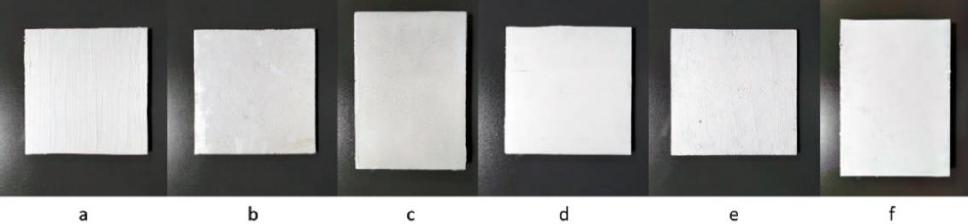
Figure 1. Investigated RR and diffusive coating samples on different substrates: ( a ) RR SW ; ( b ) RR RW ; ( c ) RR SA ; ( d ) DIFF SW ; ( e ) DIFF RW ; ( f ) DIFF SA .